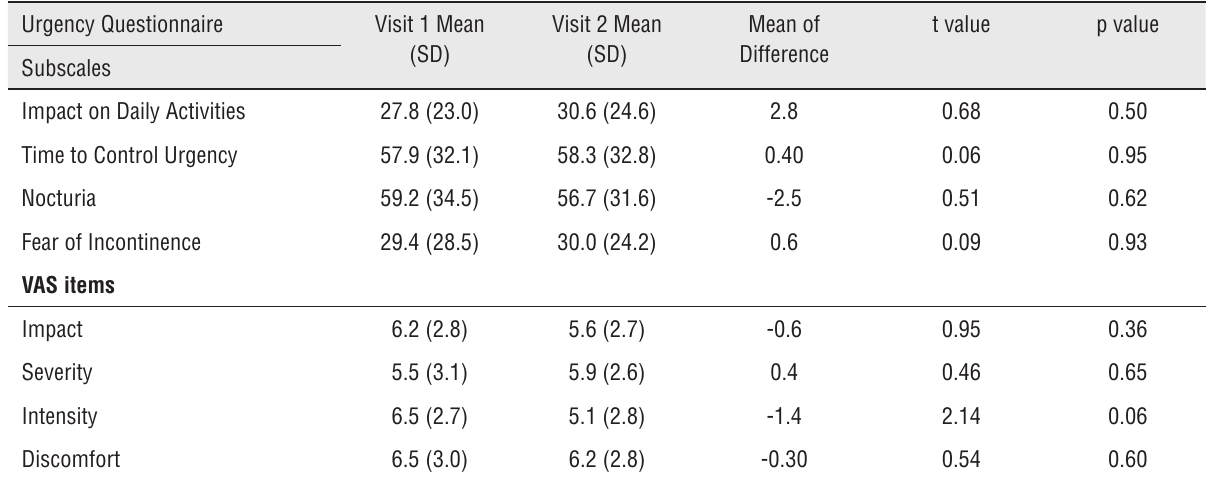
Table 5 - Comparing the scores of the UQ subscales and vAS items at visit 1 and visit 2.